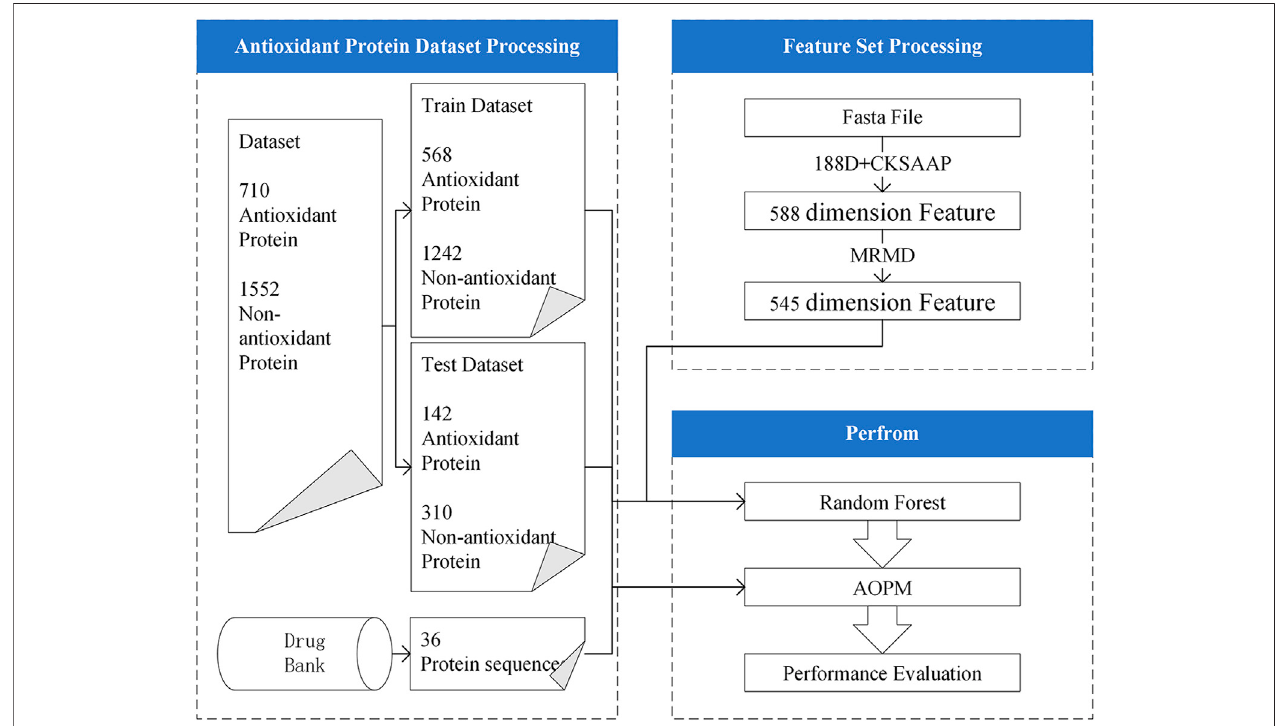
FIGURE 5 | The predicted result of the enzyme of antioxidant drugs. The predicted value of protein P00441 reached 0.99, and the predicted value of protein P48506 reached 0.79. According to related literature, protein P00441 and protein P48506 are the catalytic subunits of superoxide dismutase [Cu-Zn] and glutamate- cysteine ligase, respectively. The prediction results of the remaining proteins are also around